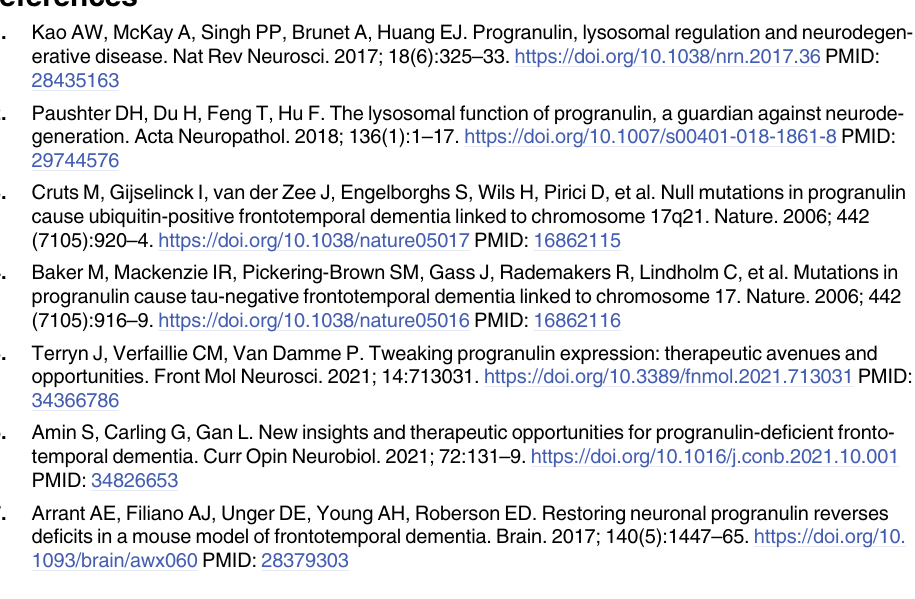
S2 Table. qPCR primer